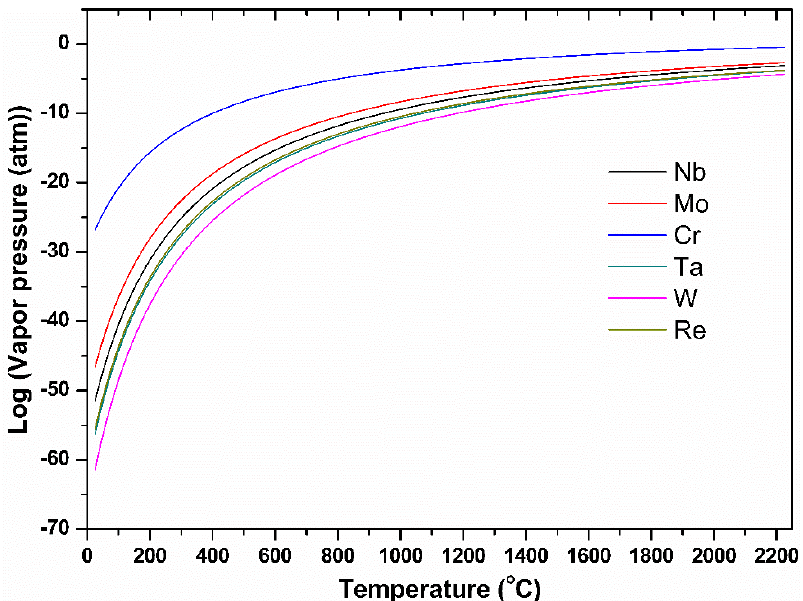
Figure 9. Image indicating the vapor pressure in log as a function of temperature (from room tem- perature to around 2200 °C).